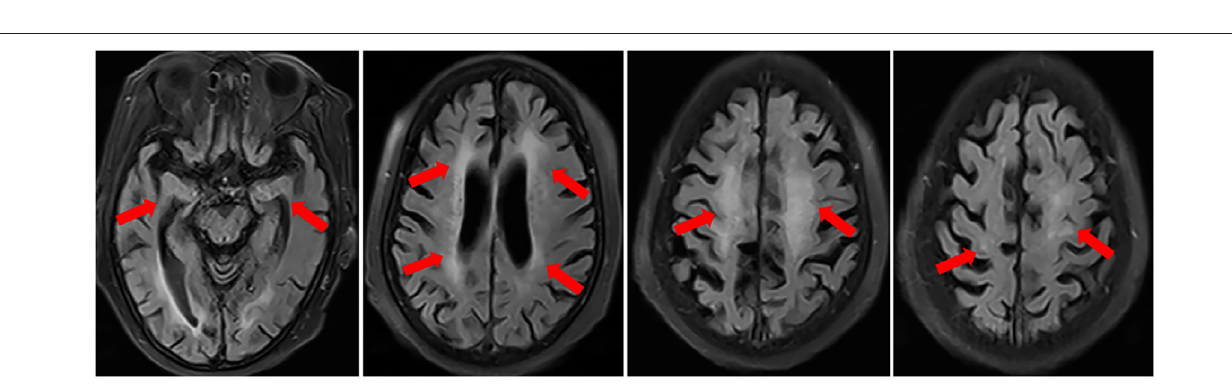
FIGURE 3 | Brain MRI in September 2019 before treatment showed new scattered foci of T2- FLAIR hyperintensity within the periventricular, deep and subcortical white matter of the frontoparietal lobe and progressive brain atrophy, especially in the hippocampus.